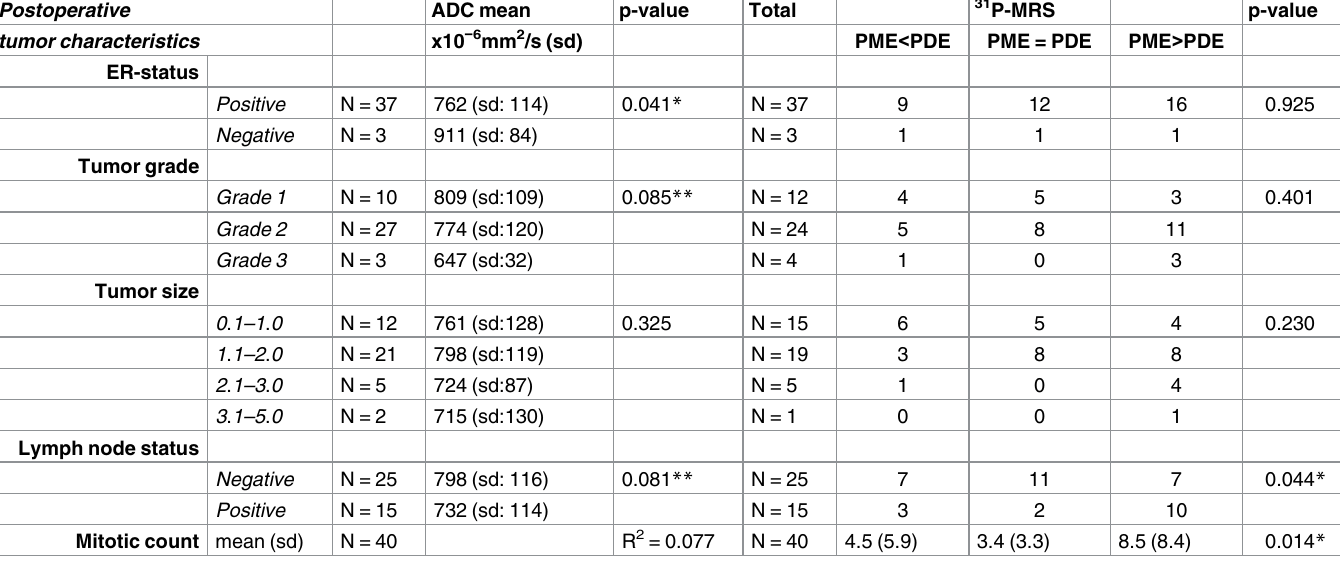
Table 3. Association between postoperative histopathology and 7T MRI characteristics. A significantassociation (p < 0.05 * )was seen betweenthe mean apparentdiffusion coefficient (ADC) on diffusionweightedimagingand estrogen receptor (ER)-status, and also betweenthe 31-phosphorus magnetic